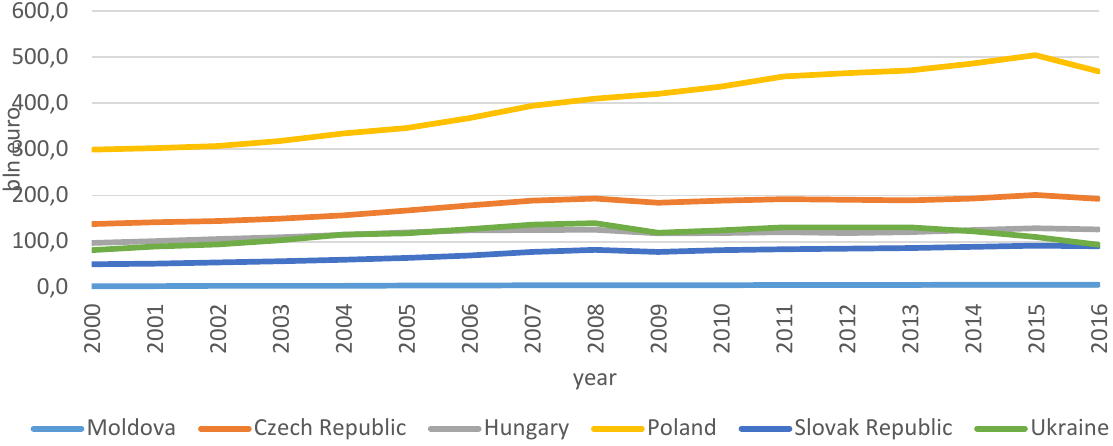
Source: Data from database: World Development Indicators.